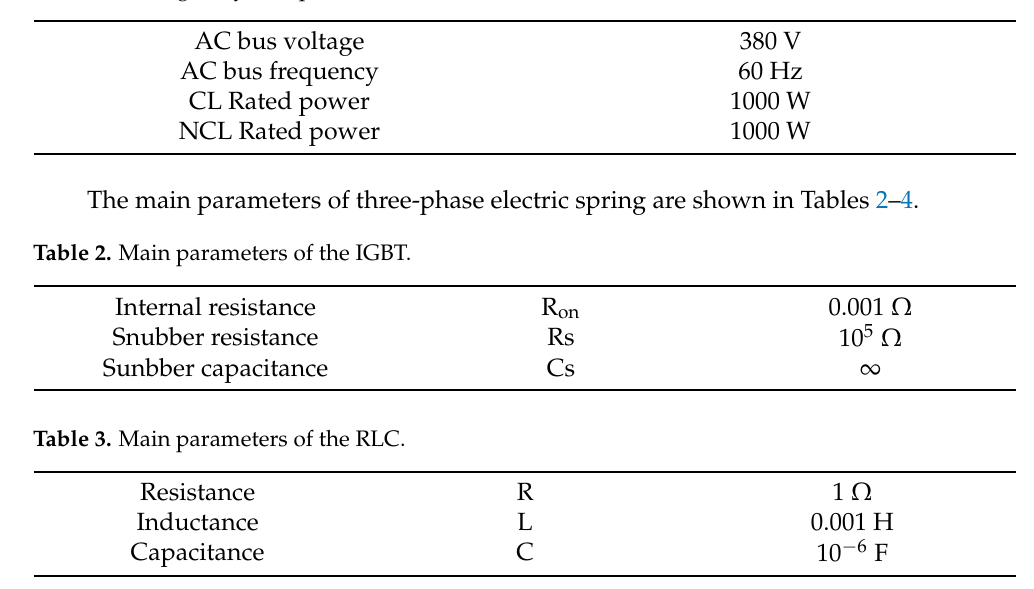
Figure 7. Decoupling control strategy of electric spring.